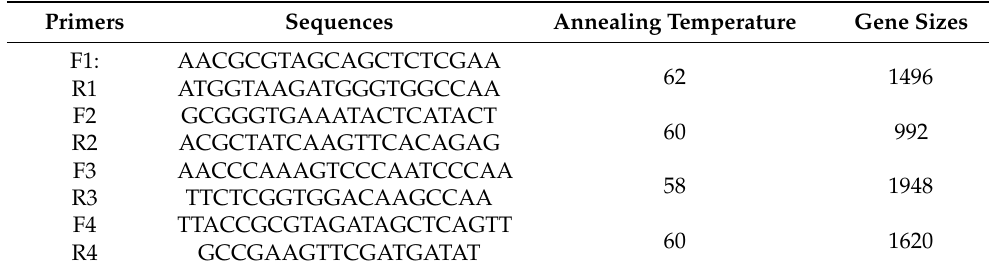
Table 3. Primers of Bos1 in B. cinerea for PCR